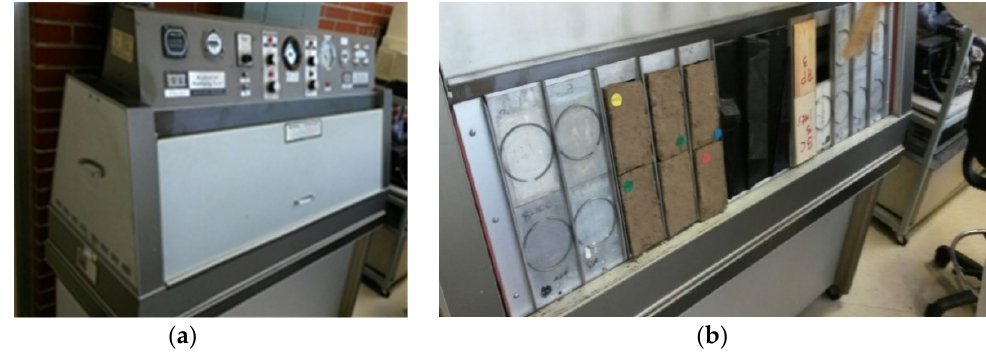
Figure 4. Accelerated weathering chamber Q-LAB, model QUV. ( a ) QUV Chamber with programmable controller, ( b ) Placement of the sample under study, inside the QUV accelerated weathering tester.